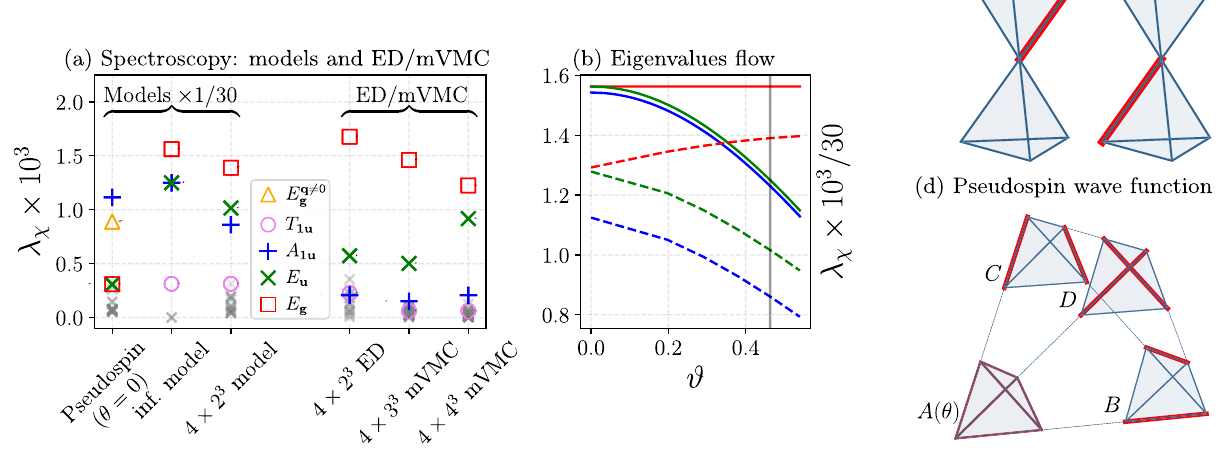
FIG. 6. (a) Eigenvalues of the dimer-dimer correlation matrix and their irreducible representations of the point group computed at the =j 0 . The gray crosses correspond to all eigenstates with small eigenvalues, irrespective of their SU ð 2 Þ -symmetric point and j 2 1 ¼ irreducible representation, including all finite momentum sectors. The E q ≠ 0 g state is degenerate in the momentum sectors ð 0 ; π ; π Þ ; ð π ; 0 ; π Þ ; ð π ; π ; 0 Þ . (b) Evolution of eigenvalues (× 1 = 30 ) within the infinite-volume (solid lines) and the 4 × 2 3 -site models (dashed lines) as a function of ϑ . The colors coincide with the representation notations of panel (a). For the infinite-volume model, the blue line ( A 1 ) is slightly shifted for visibility as it always remains degenerate with E . (c) Fully dimerized j α i (left) and j β i (right) wave u u functions. (d) Pseudospin wave function introduced in Ref.